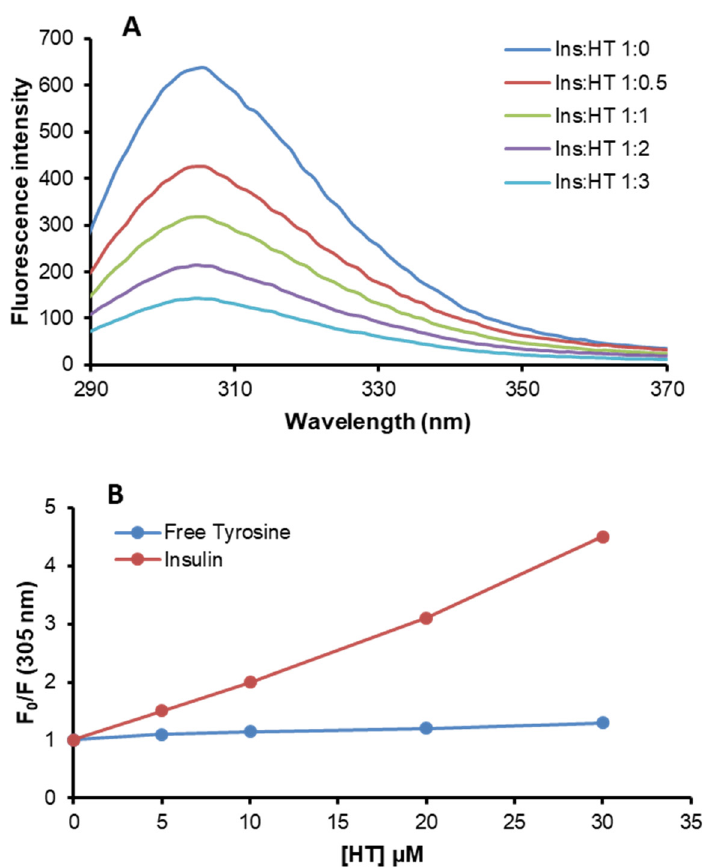
Figure 7. Insulin-HT interaction monitored by fluorescence spectroscopy. ( A ) Tyrosine fluorescence emission was evaluated in both insulin and free tyrosine after addition of HT at different molar ratios (1:0, 1:0.5, 1:1, 1:2, 1:3). ( B ) Stern–Volmer plot of tyrosine quenching by HT. Working concentrations were 10 µM for insulin and 40 µM for free tyrosine. Other experimental details are described in the Methods section.